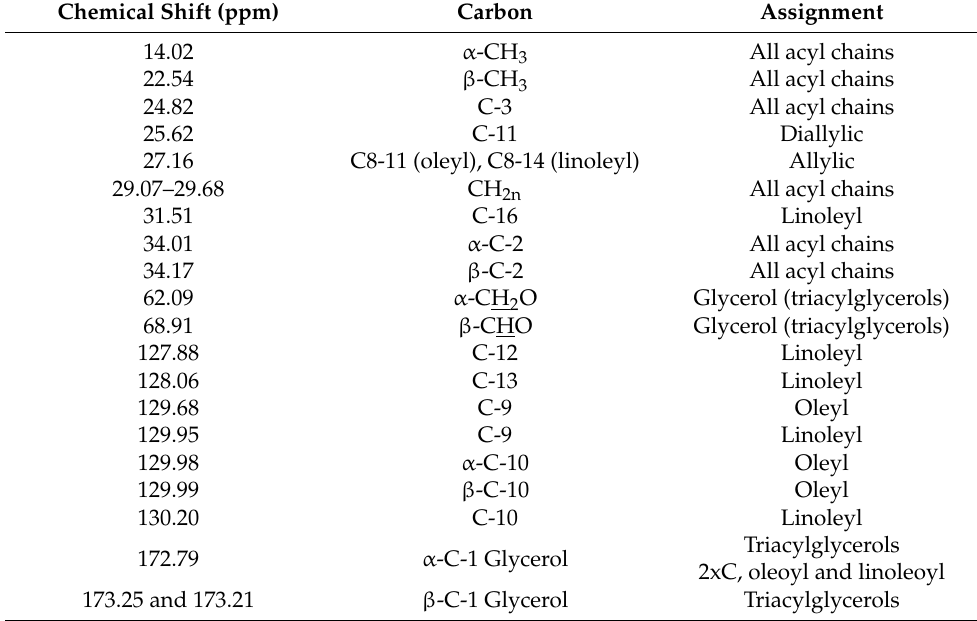
Table 3. Chemical shifts and assignments of the characteristic signals in the carbon nuclear magnetic response ( 13 C-NMR) spectrum of crude seed